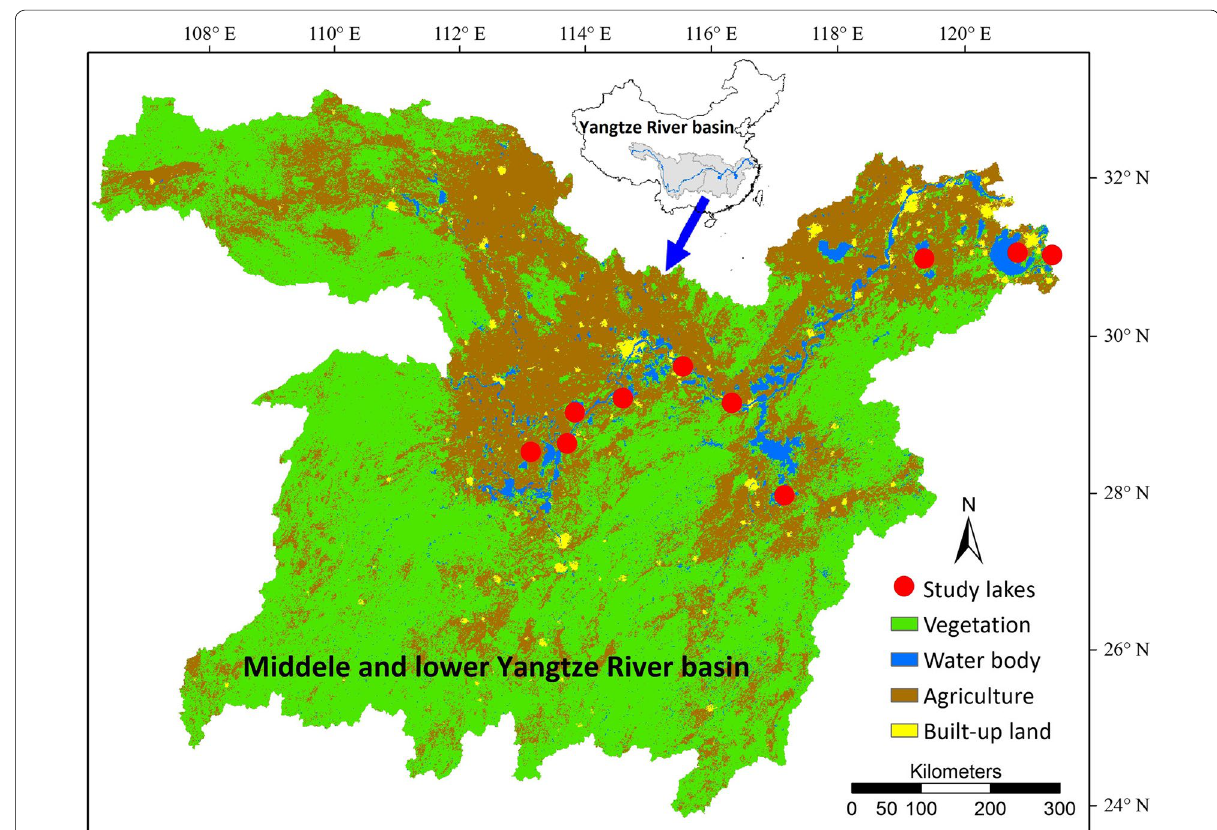
Fig. 1 Location of ten study lakes in the Yangtze River